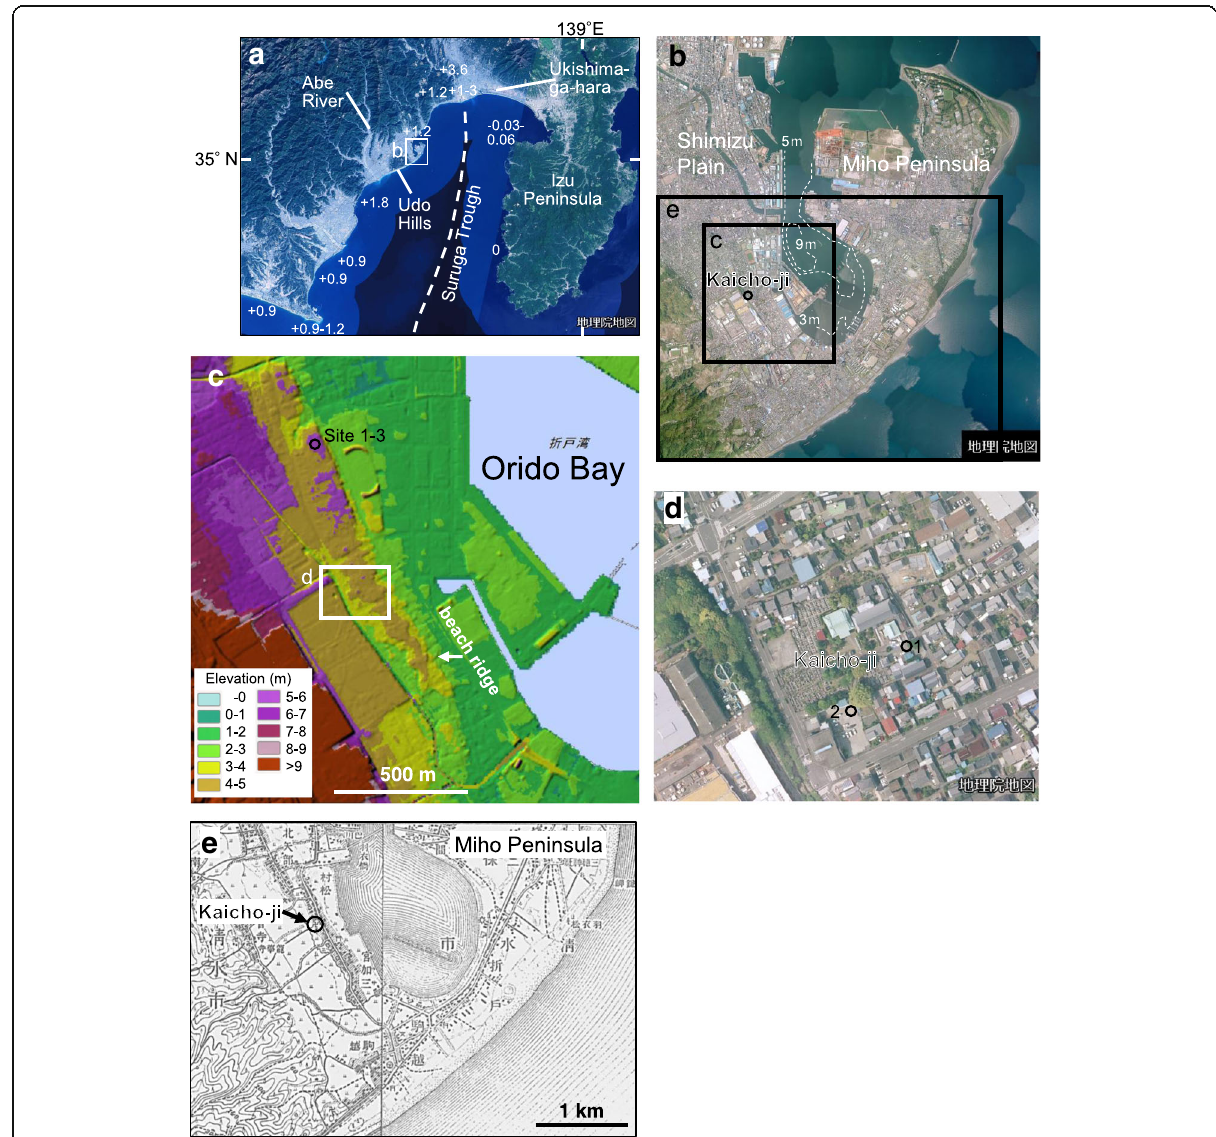
Fig. 2 Locality map of the study area. a Estimated coseismic vertical crustal displacement (m) resulting from the AD 1854 Ansei-Tokai earthquake along the coast of Suruga Bay (after Ishibashi (1984) and Kitamura and Kobayashi (2014)). b Locations of Shimizu Plain, Orido Bay, and Miho Peninsula, showing isobaths are based on Tsuchi (1955). c Location of the study area. The figure is modified from a map issued by the Geospatial Information Authority of Japan (http://maps.gsi.go.jp/). d Aerial photograph of the study area, used with permission from the Geospatial Information Authority of Japan (https://maps.gsi.go.jp/development/ichiran.html). e Topographic map of the Shizuoka and Komagoe districts (1:25,000 scale, compiled in 1932), showing the location of the study